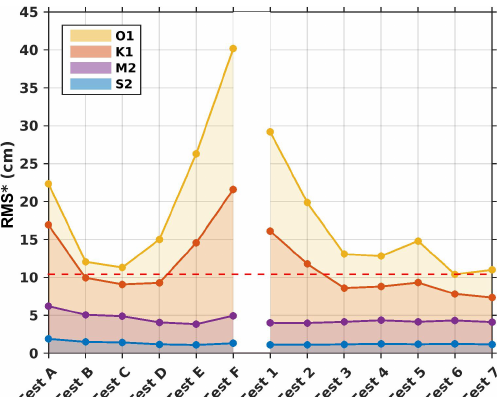
Figure 13. Model complex errors (Appendix; Eq. A2) relative to altimetry data for tests listed in Table 1 performed with nonuniform values of z 0 (SET3 and SET4). The space in between two lines cor- responds to the errors for each wave. The yellow line corresponds to the cumulative errors for all four waves. The dashed red line cor- responds to the smallest cumulative error, found for Test 6 (SET4), equal to